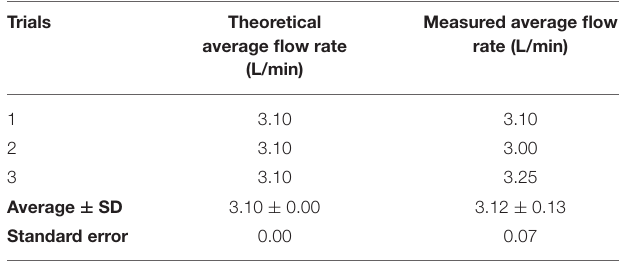
TABLE 4 | The theoretical average flow rate vs. the measured average flow rate, standard deviation (SD), and standard error during pulsatile flow.